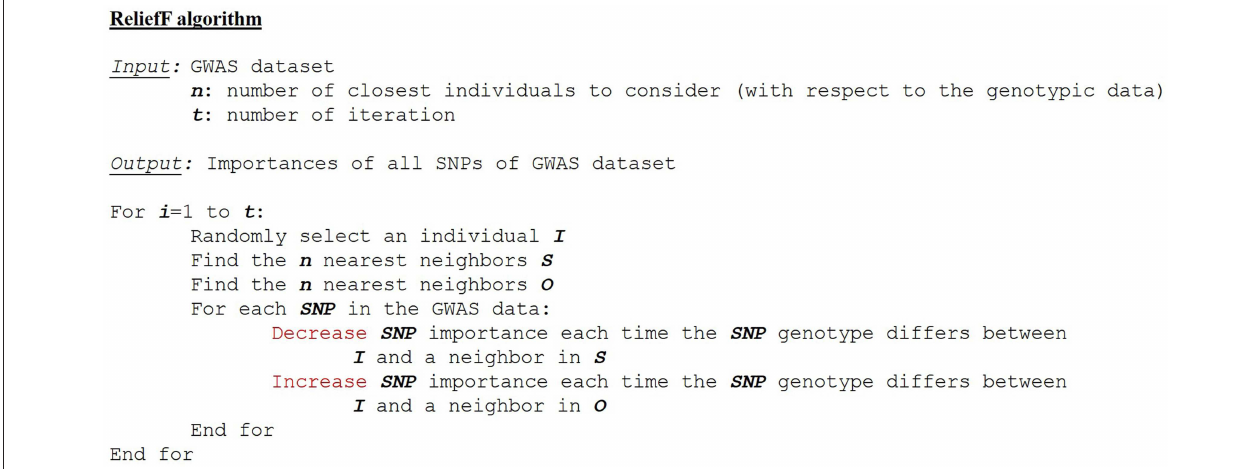
FIGURE 5 | ReliefF